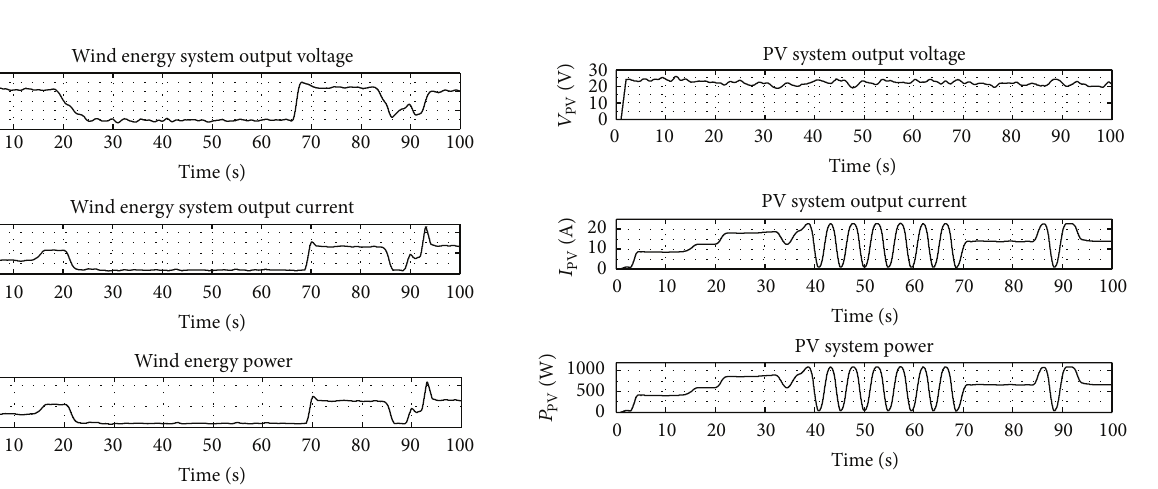
generation system according to the load